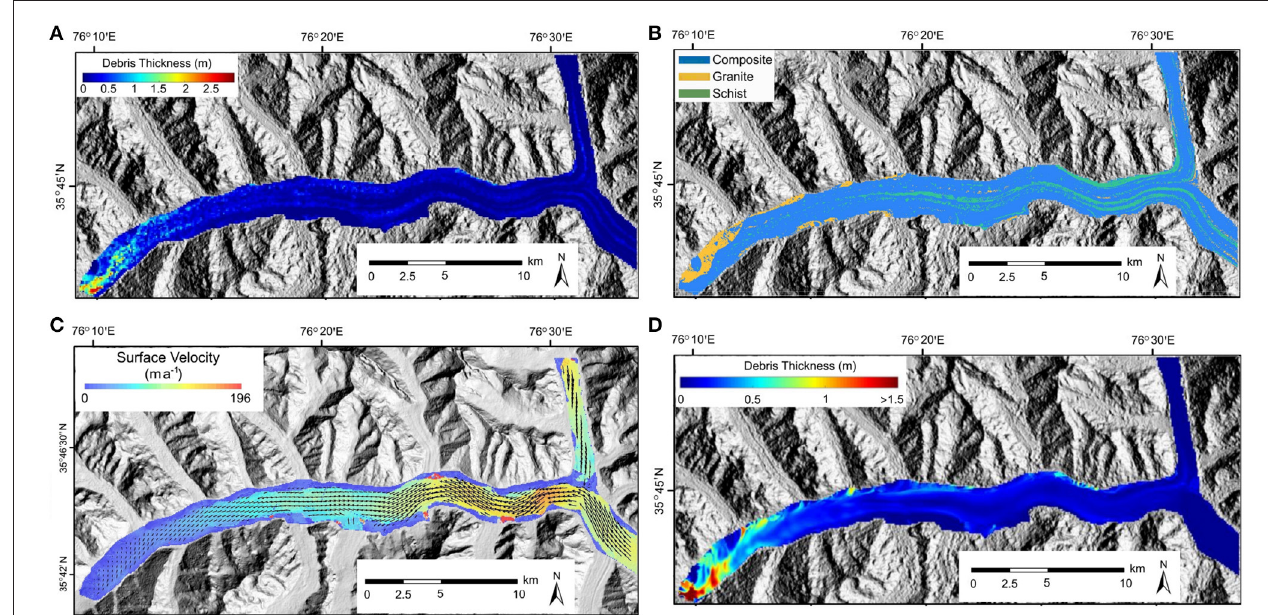
FIGURE 5 | Supraglacial debris conditions for the Baltoro Glacier. (A) The debris-thickness distribution over the Baltoro glacier in summer 2004 computed from ASTER surface kinetic temperature data following the approach by Mihalcea et al. (2008). (B) Debris rock type distribution over the Baltoro Glacier in 2004 based on the remote-sensing analysis by Gibson et al. (2017). (C) Surface ice-flow velocity of the Baltoro Glacier estimated from a Landsat-8 OLI panchromatic image pair acquired on September 15, 2004 and September 2, 2005. (D) Simulated debris transport due to ice-flow (advection process) over a 50-year period. Result represents the debris thickness distribution for year